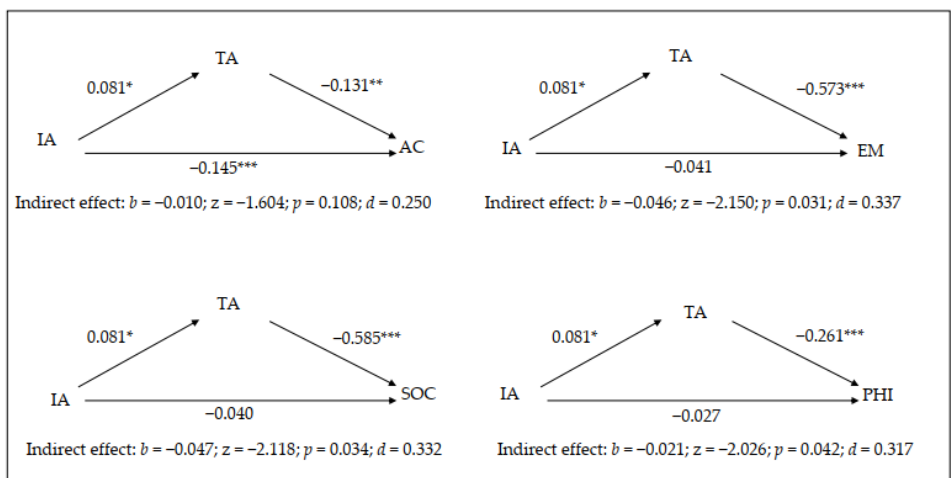
Figure 3. Figure 3. Graphical representation of the results of the mediation model for the inattention symptomatology.